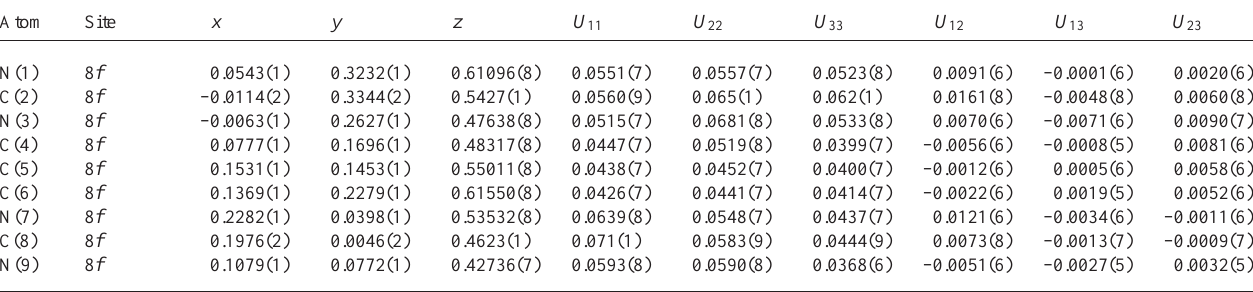
Table 3. Atomic coordinates and displacement parameters (in Å 2 ) .